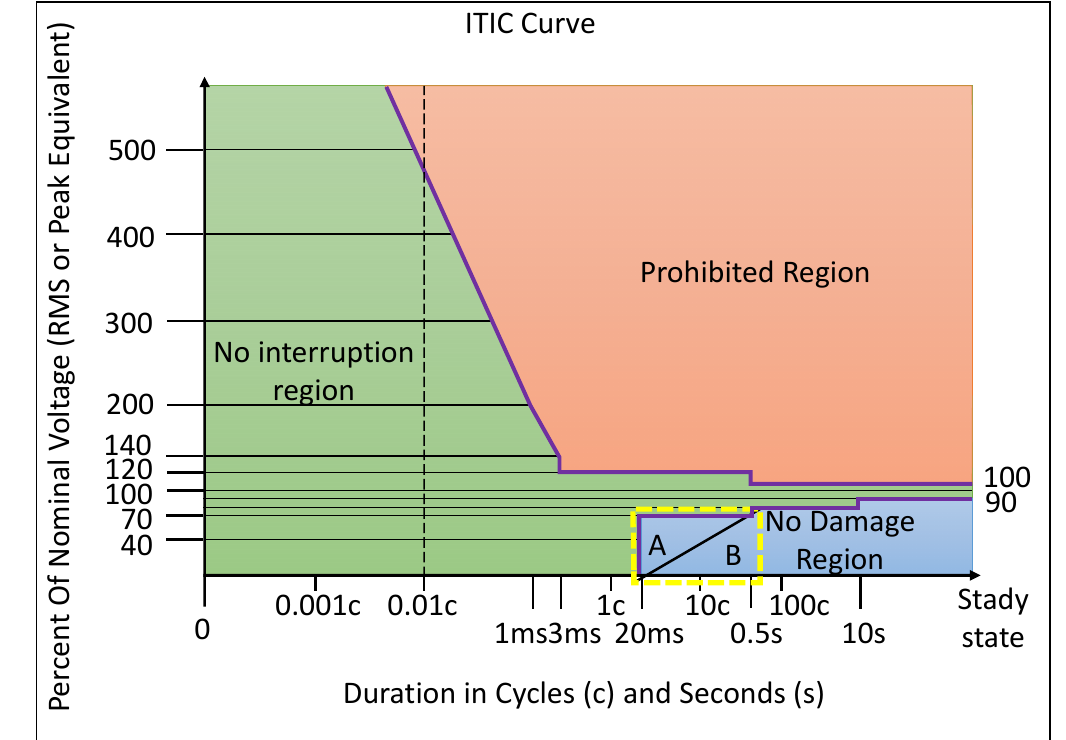
Figure 1. ITIC/SEMI F47 curve describing the permissible range of changes in the voltage supply- ing the IT device as a function of time (the area marked with a dashed yellow line revealed the forbidden states).